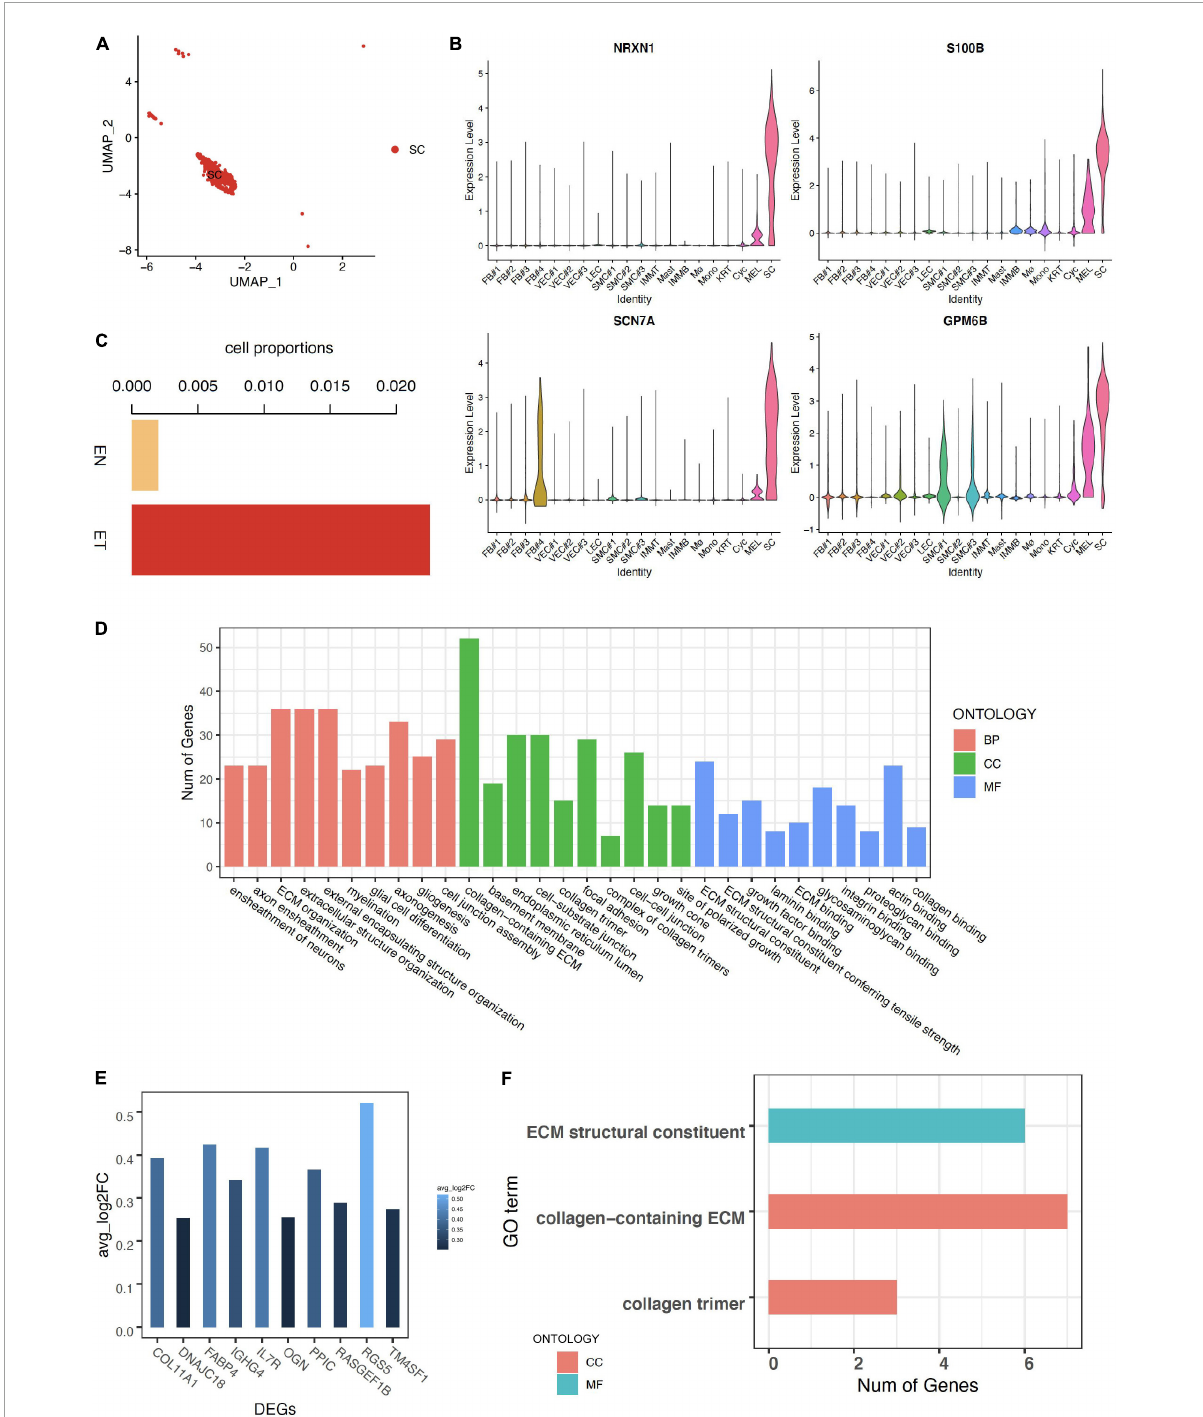
FIGURE3 Characteristics of Schwann cells in earlobe keloid. (A) Uniform Manifold Approximation and Projection (UMAP) plots of Schwann cells. (B) The expression of classical markers in Schwann cells. (C) The cell proportions of Schwann cells between normal skin sample (EN) and earlobe keloid samples (ET). (D) GO terms of Biological Process (BP), Cellular Component (CC), and Molecular Function (MF). Here we showed the top 10 categories ordered by P -value ( < 0.05) and gene counts for each ontology. (E) The expression of upregulated DEGs in Schwann cells between earlobe keloid samples (ET) and normal skin sample (EN). Here we showed the top 10 DEGs ordered by P -value ( < 0.05) and log2 fold change (avg_log2FC > 0.25). (F) GO terms of cellular component (CC) and molecular function (MF) of DEGs in Schwann cells between keloid and normal scars ( P -value <